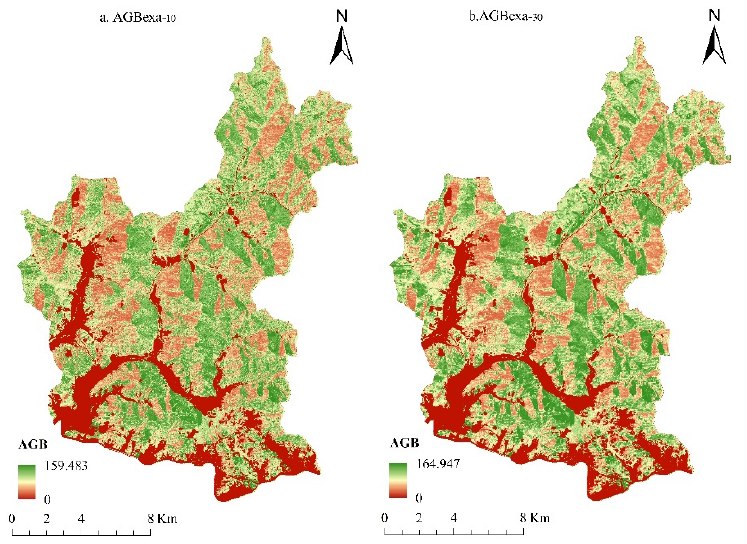
Figure 6. Relative values of the AGB extracted by using estimated AGB of GF-2 at 10 m and 30 m spatial resolution. ( a ) Relative value of the AGB of 10 m; ( b ) Relative value of the AGB of 30 m. (Unit was t/ha). Table 6. The statistical information of relative true value of the AGB using various remote sens- ing data.